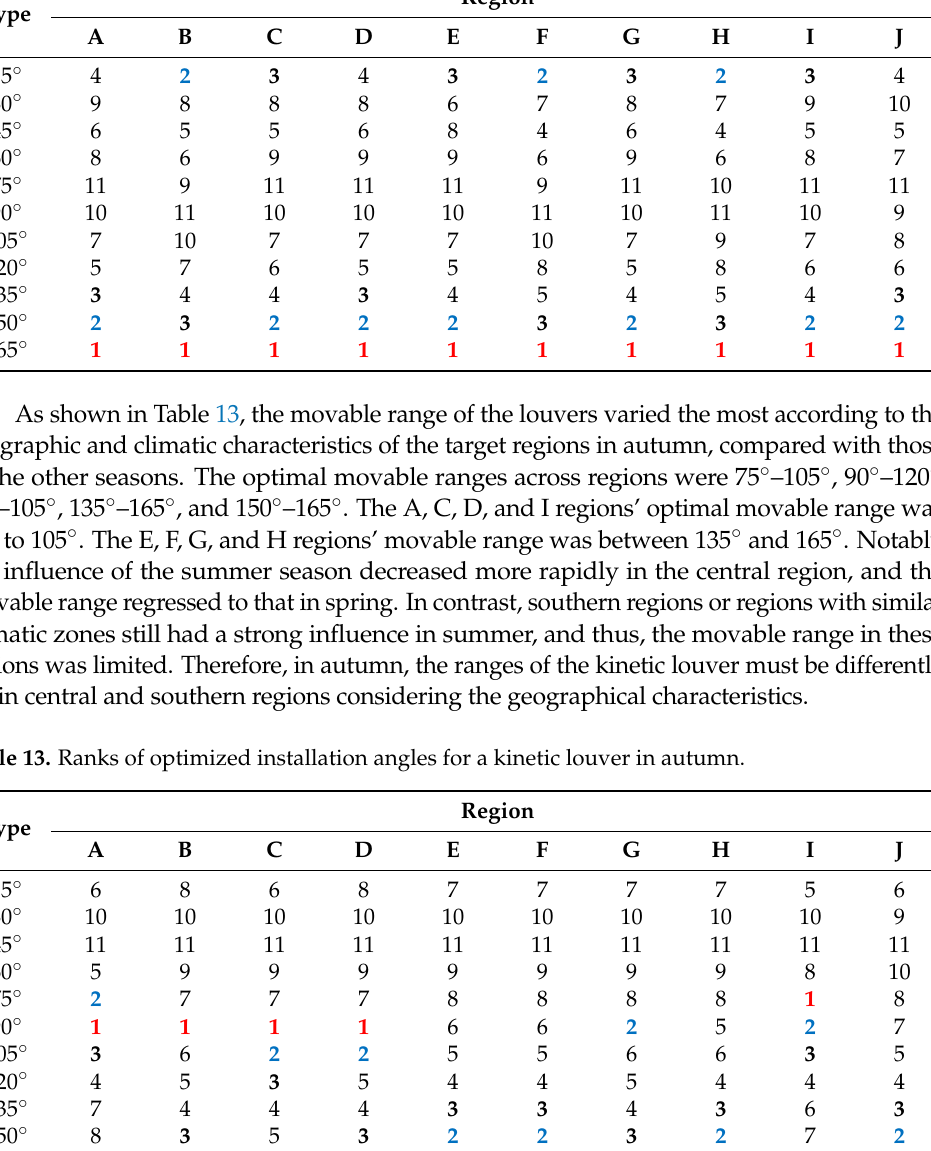
Table 12. Ranks of optimized installation angles for a kinetic louver in summer. Type